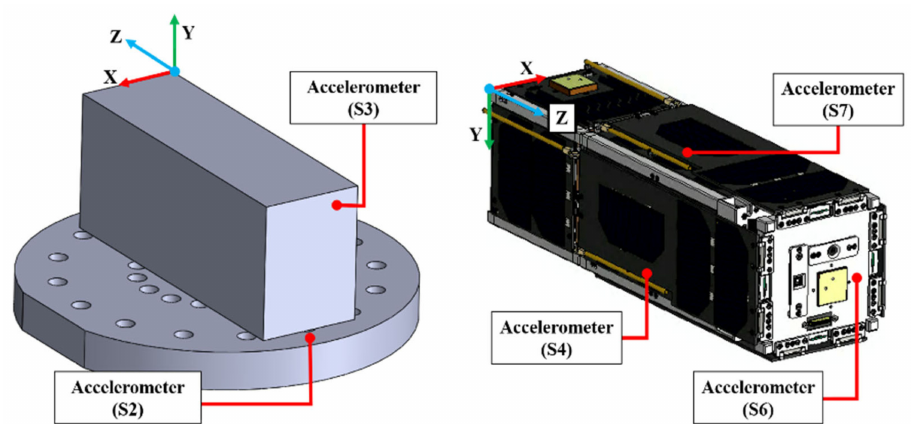
Figure 12. Accelerometer attachment locations. The three accelerometers were located in Pumbaa’s − X-axis DSP, − Y-axis DSP, and +Z-axis panel. The other two accelerometers were located in the test P-POD and fixture.